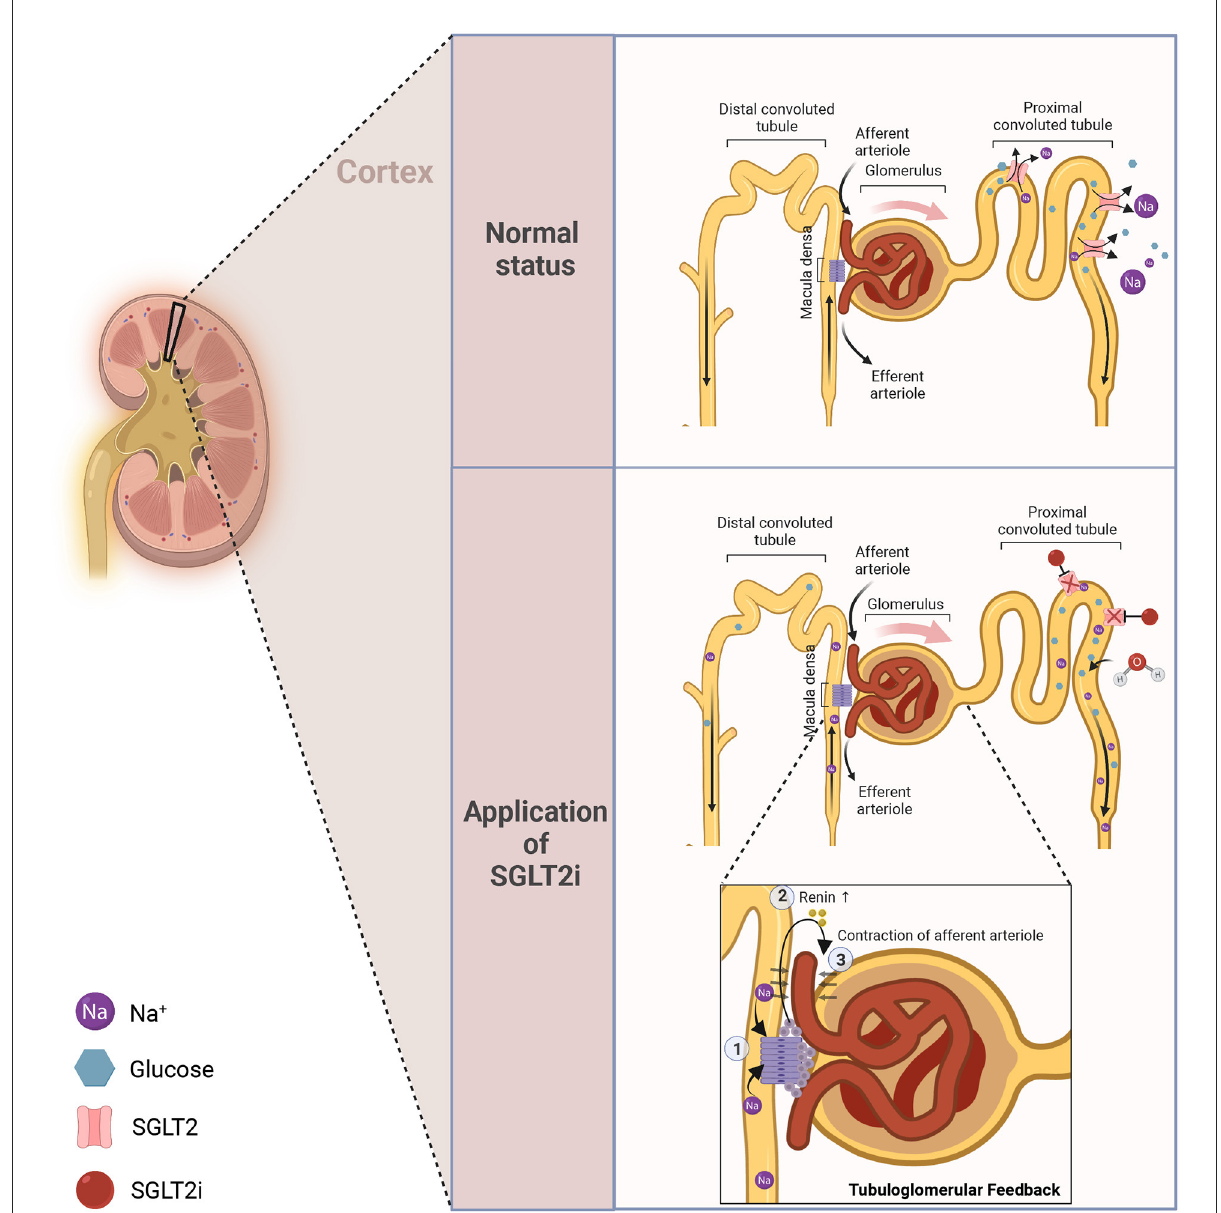
FIGURE1 The anti-hyperglycemic mechanism of SGLT2i. In normal status, glucose and Na + can be efficiently reabsorbed at the site of the proximal convoluted tubule to maintain glucose homeostasis. Once applied with SGLT2i, such reabsorption will be inhibited, thereby leading to diuresis and